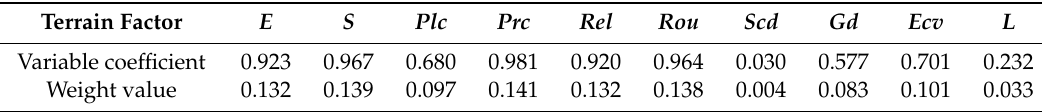
Table 3. Variation coe ffi cients and weight values of terrain factors.